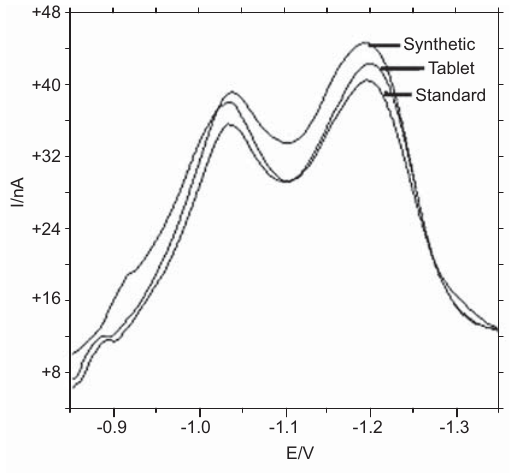
Figure 12 Voltammograms of synthetic preparation, tablet and standard solution for DPAdSV (210.00 ng/ml